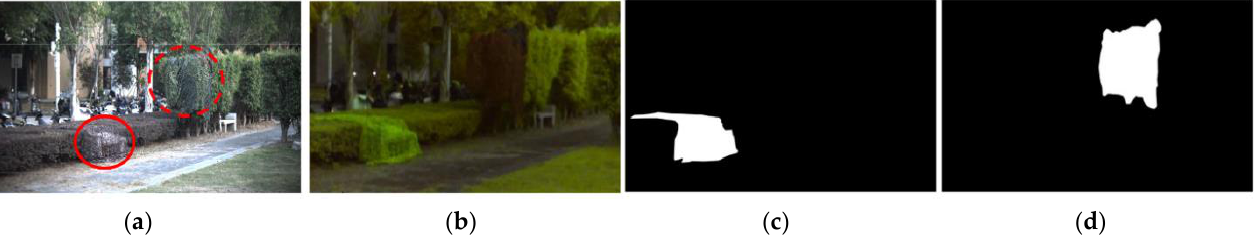
Figure 10. (a) The visible image of the BT scene, where the ASRC-net is circled by the solid line and the AIRC-net is circled by the dashed line; (b) The false-color image of the BT scene; (c) The reference image of the ASRC-net; (d) The reference image of the AIRC-net.